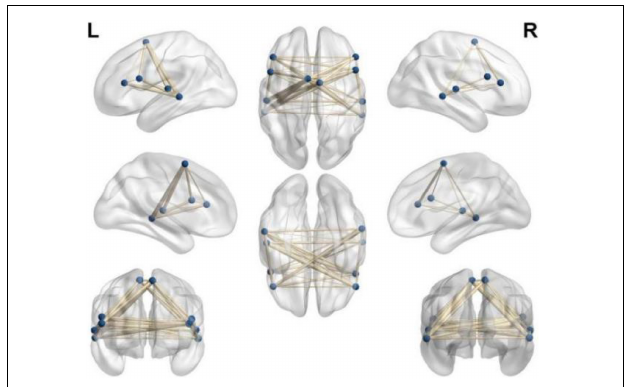
FIGURE 3 | Select ROI function connection pairwise comparison function connection diagram ( p <